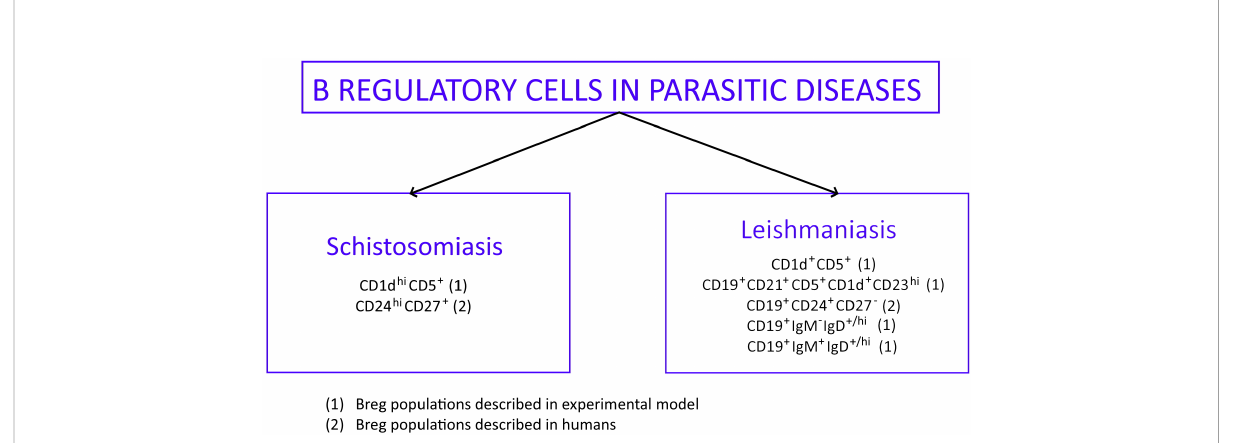
FIGURE 2 Phenotypic pro fi le of Bregs described in parasitic diseases: schistosomiasis and leishmaniasis. Bregs phenotypes found in experimental models are marked (1) while Bregs phenotypes isolated from humans are marked